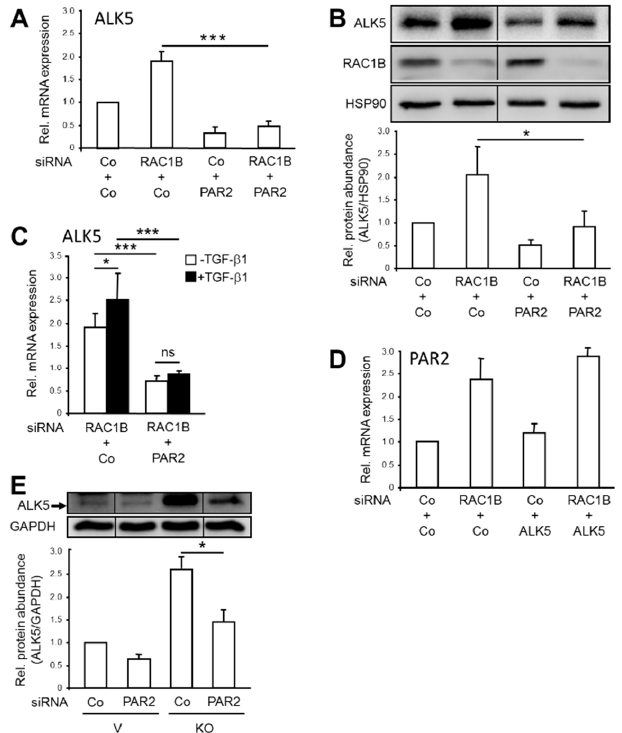
Figure 2. Effect of PAR2 knockdown on RAC1B knockdown-induced ALK5 expression in Panc1 cells. ( A ) Panc1 cells were transfected twice with 25 nM each of Co siRNAs specific for RAC1B and PAR2, 25 nM each of RAC1B siRNA + Co siRNA specific for PAR2, or 25 nM each of RAC1B siRNA + PAR2